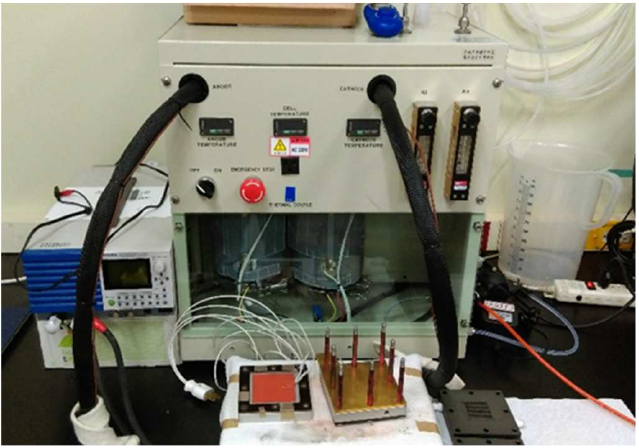
Figure 4. A machine for measuring fuel cells.